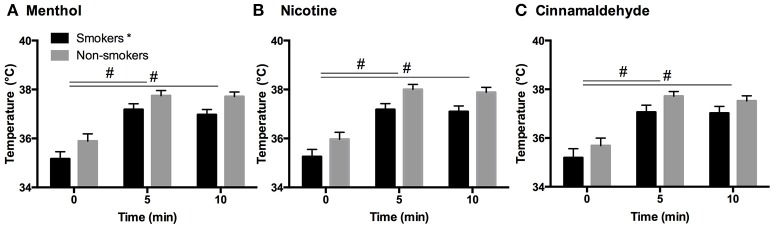
Intra-oral temperature in response to menthol (A), nicotine (B), and cinnamaldehyde (C) before, during (5 min) and immediately after chewing (10 min). The basal temperature for smokers was shown to be lower compared to non-smokers, however, an elevation in temperature in the first half of chewing was evident for both smokers and non-smokers and in response to all gums. *Significant difference between groups. #Significant change in temperature over time. Data presented as mean ± SEM.